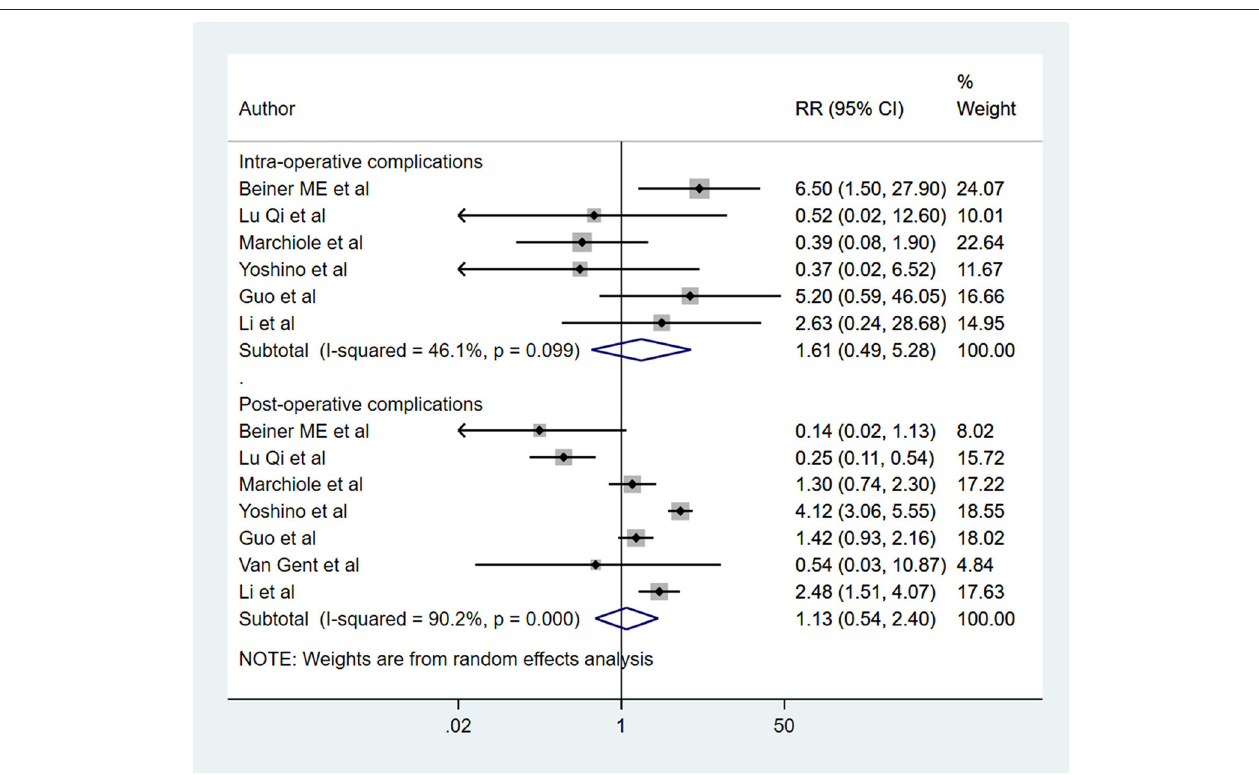
FIGURE 4 | The pooled effect size for the intra-operative and post-operative complications based on the comparison between radical trachelectomy and hysterectomy in patients with early-stage cervical cancer.